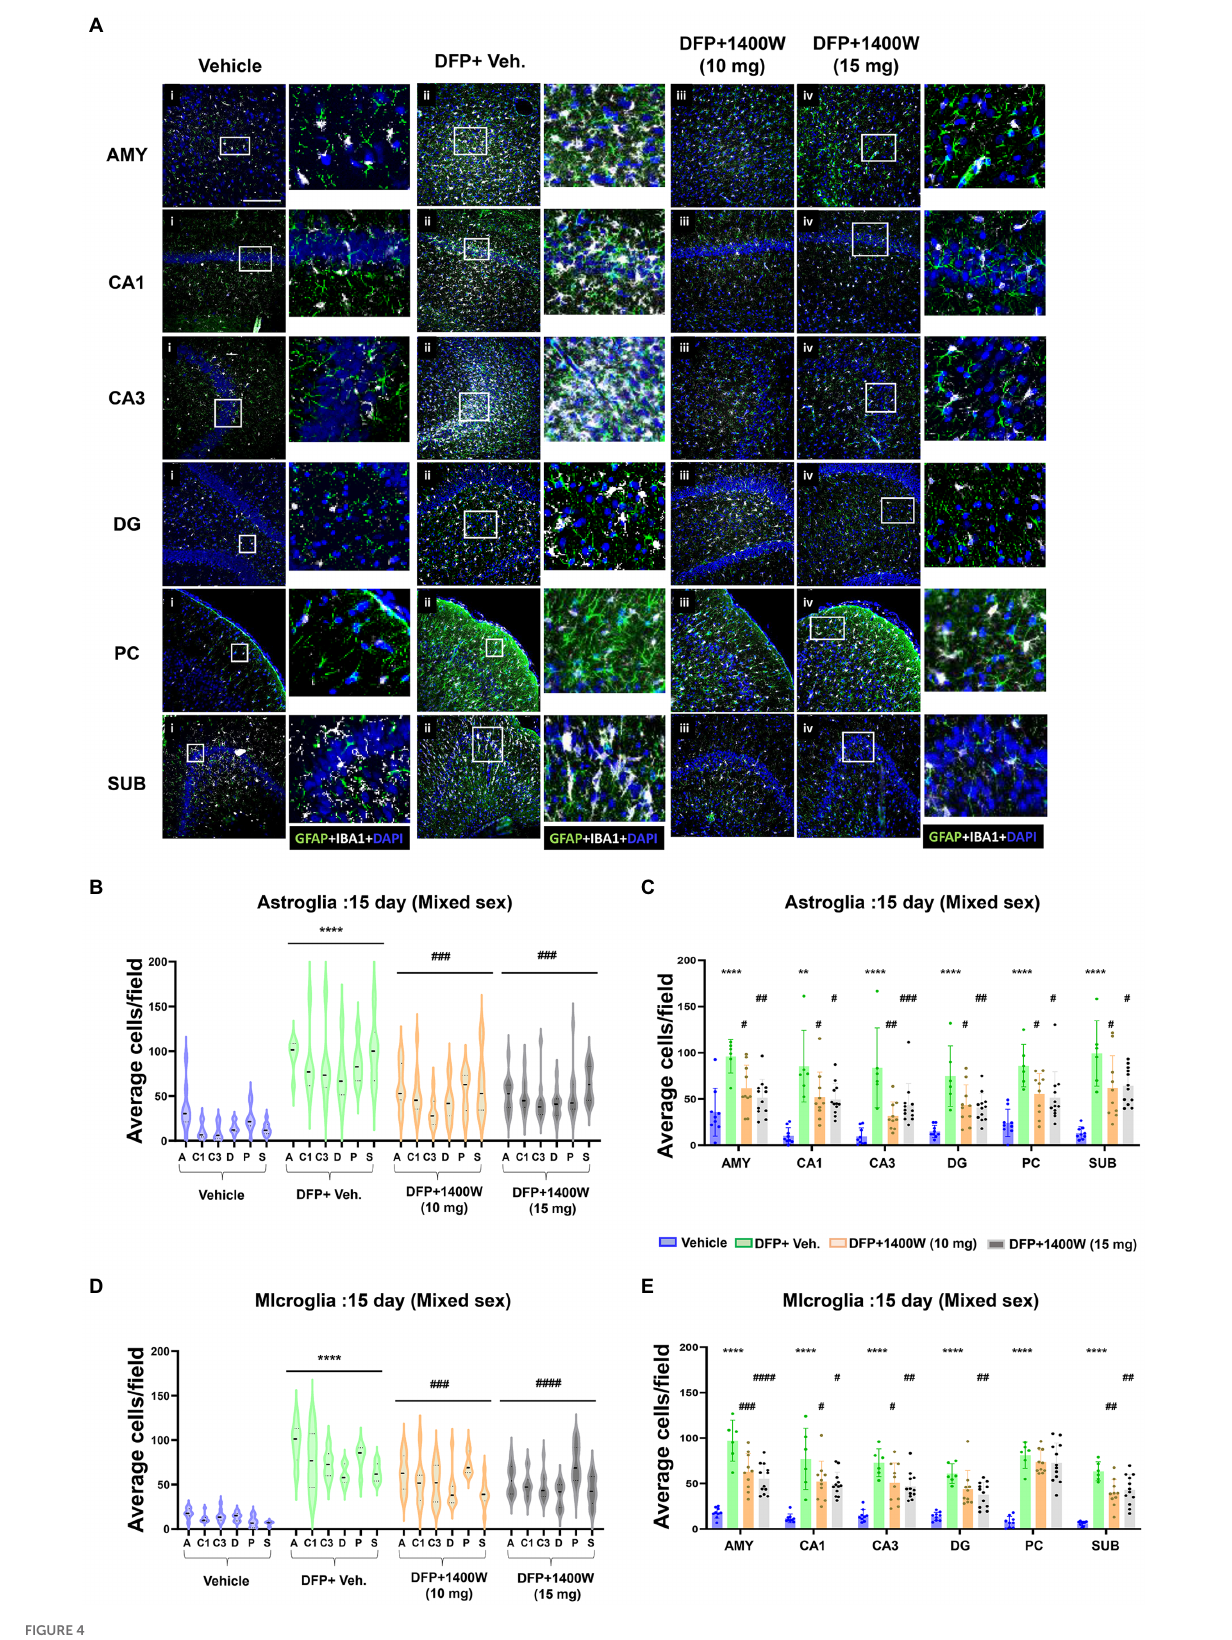
FIGURE 4 The effects of 1400W treatment for 2 weeks on DFP-induced astrogliosis and microgliosis. Representative images of GFAP (green, for astrocytes) and IBA1 (gray, for microglia) positive cells representing Amygdala (AMY), CA1, CA3, Dentate gyrus (DG), Piriform Cortex (PC), Subiculum (SUB) regions